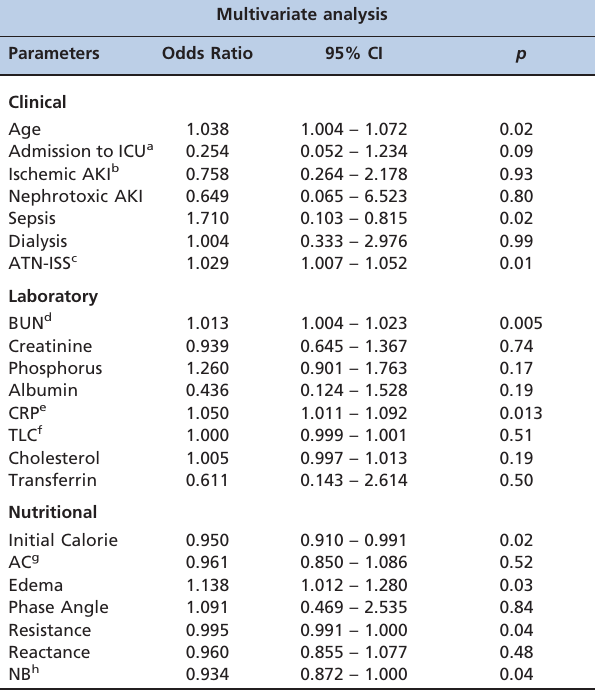
Table 4 - Multivariable analysis of the clinical, laboratory, and nutritional parameters associated with death.